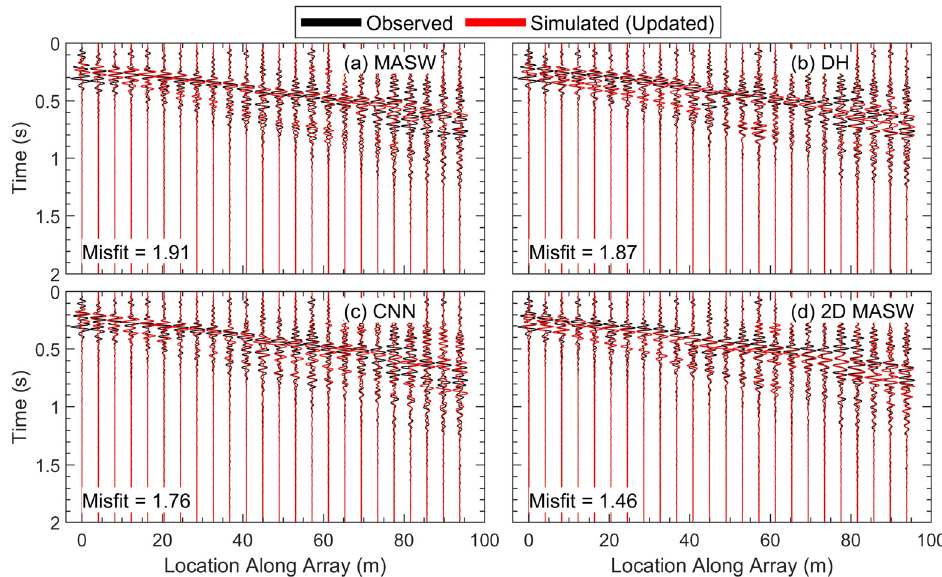
Figure 11. Normalized observed and simulated waveforms from Shot 1 ( − 24 m) for the final, updated models at the end of FWI Stage 4 (10 to 30 Hz) based on the: ( a ) MASW, ( b ) DH, ( c ) CNN, and ( d ) 2D MASW starting models. GSOTD misfit values for each set of simulated waveforms are shown in the bottom left of each plot. Note that for clarity purposes, the waveforms are only shown for every fourth channel used for FWI.